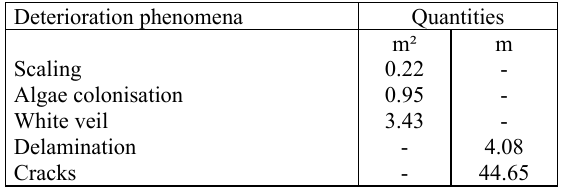
Table 1 . Table export from the BIM model: quantities (area and length) of some deterioration phenomena